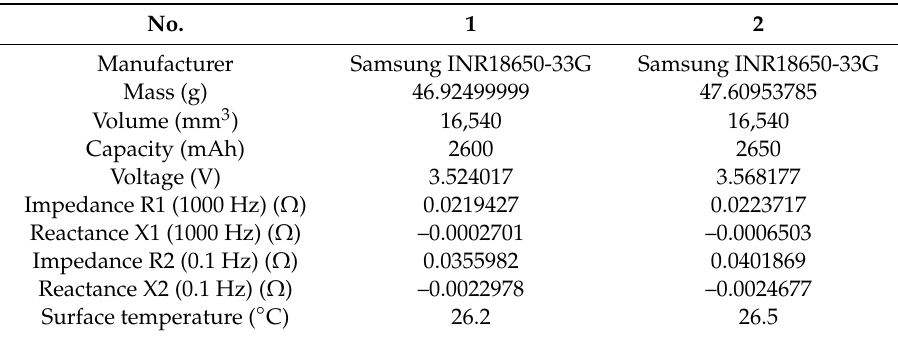
Table 2. Examples of parameters for two batteries.